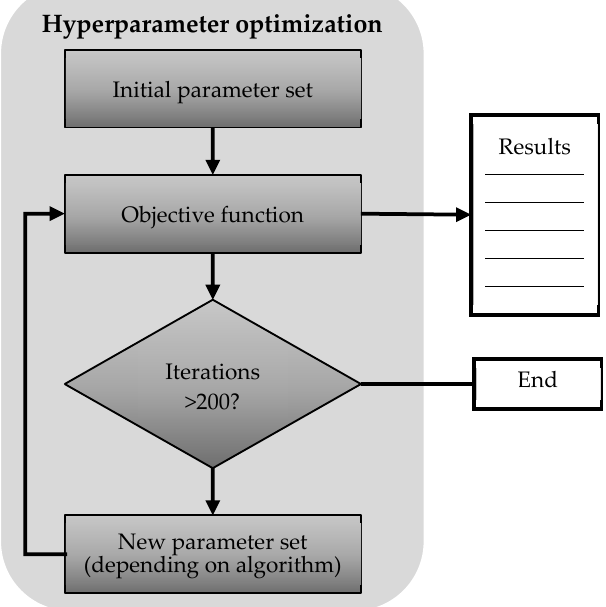
Figure 5. Schematic flow of a general hyperparameter optimization process.